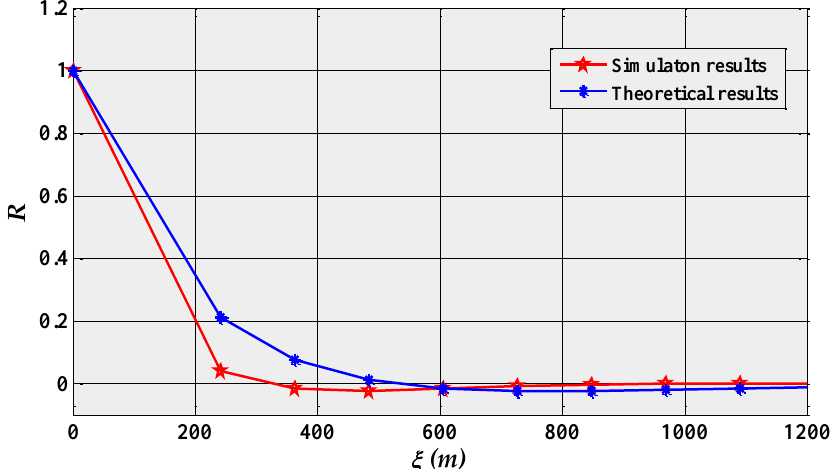
Figure 8. Comparisons of correlation values between simulation results and theoretical calcula- tion.